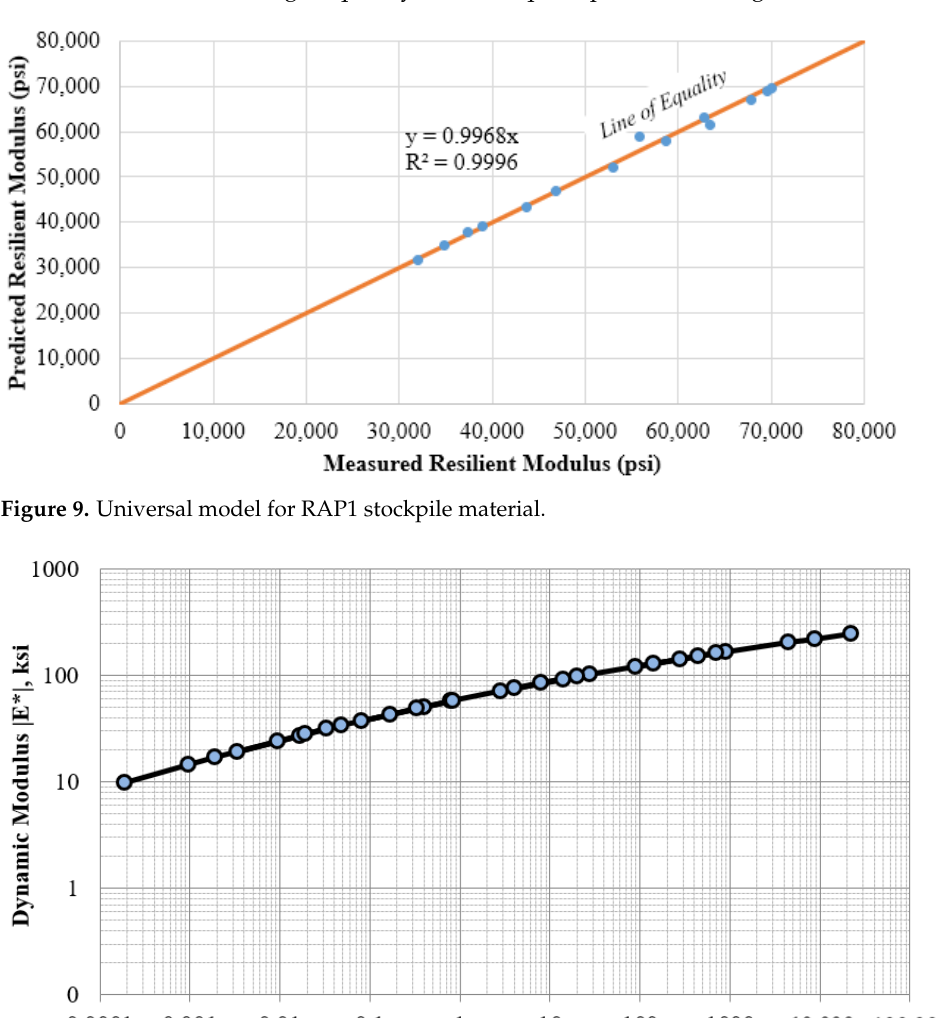
Table 5. Regression coefficients of Universal model for RAP materials.